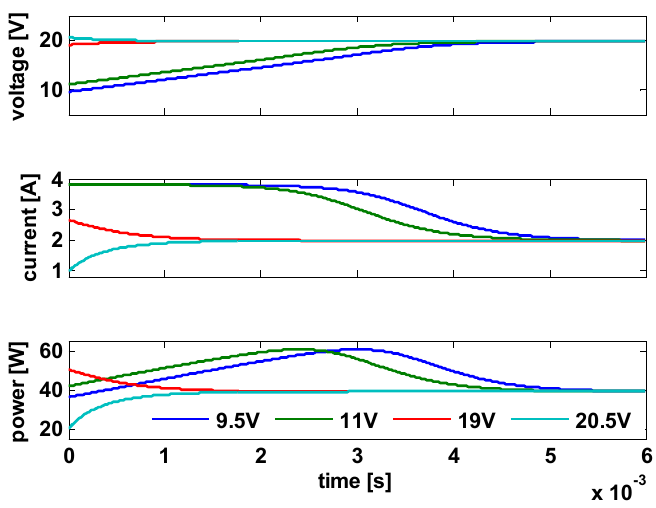
Figure 19. PSIM software simulation circuit diagram.